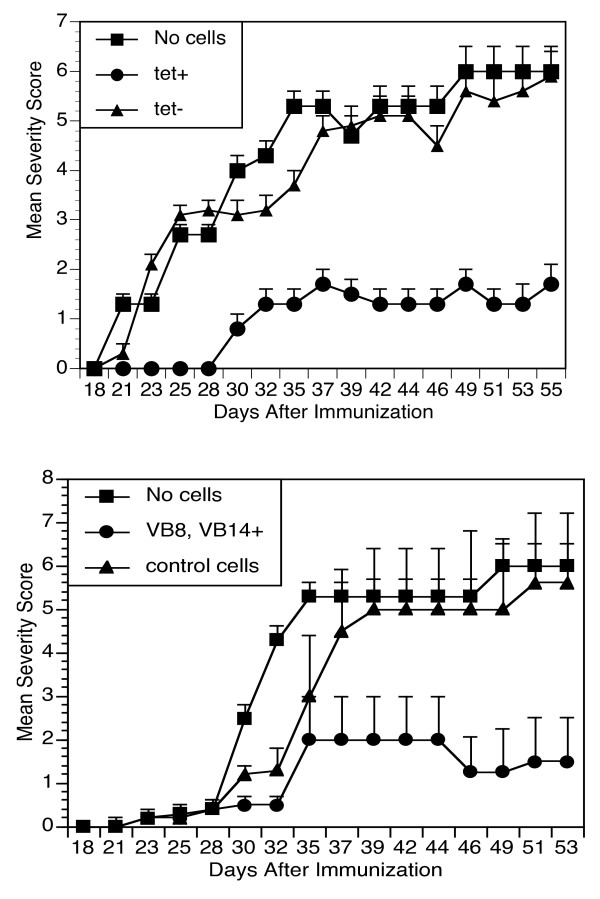
Cell transfer: prevention of arthritis. Tetramer+ T cells from draining lymph nodes were collected from DR1Tg mice immunized 10 days earlier with A12/CFA. DR1 mice (n = 3) were infused with 2 × 105 cells of either tetramer+ or tetramer-, A12-primed CD4+ T cells. All recipients were immunized with CII/CFA on the day of the cell transfer and observed for arthritis. (A) Mean severity scores over time. As indicated, only the tetramer+ A12-immune cells could prevent collagen-induced arthritis (final severity scores comparing square versus triangle of 1.3 ± 2.5 versus 5.4 ± 3.2; P ≤ 0.01. The cell-transfer experiments have been repeated with both unfractionated cells and VB8+, VB14+ purified T cells from A12-immunized lymph nodes with similar results. Suppression of established arthritis (B). Inguinal lymph node cells from A12-immunized DR1 mice were fractionated into a VB8, VB14+ population and a VB8, VB14- population. DR1 mice (n = 10) were immunized with CII/CFA and observed for the development of arthritis. On day 23 after immunization, when arthritis was established, each mouse was infused intravenously with 5 × 105 cells of either VB8, VB14+ T cells (enriched for 7.5 × 104 tetramer+ cells) or VB8, VB14- T cells. (B) Mean severity scores over time. As shown, only the VB8, VB14+ A12-immune T cells could suppress active arthritis in the collagen-induced arthritis model (final severity scores comparing (triangle versus circle) of 1.5 ± 1.0 versus 5.6 ± 1.6; P ≤ 0.03). Data shown are representative of three separate experiments.